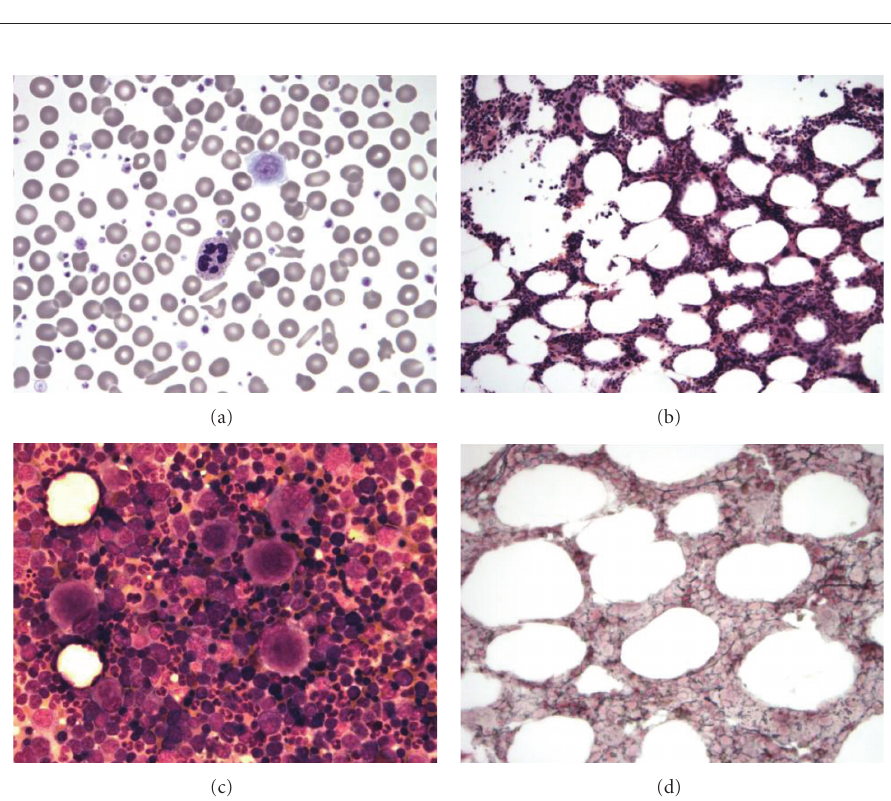
Figure 1: Primary myelofibrosis, prefibrotic stage: (a) peripheral blood, thrombocytosis with giant platelets, Wright-Giemsa stain, Ob. 100x, immersion oil. (b) bone marrow biopsy with mildly hypercellular bone marrow, hematoxylin and eosin stain, Ob. 40x. (c) bone marrow aspirate, dysmegakaryopoiesis, Wright Giemsa stain, Ob. 100x, immersion oil. (d) Reticulin stain, mildly increased reticulin deposition. Ob.